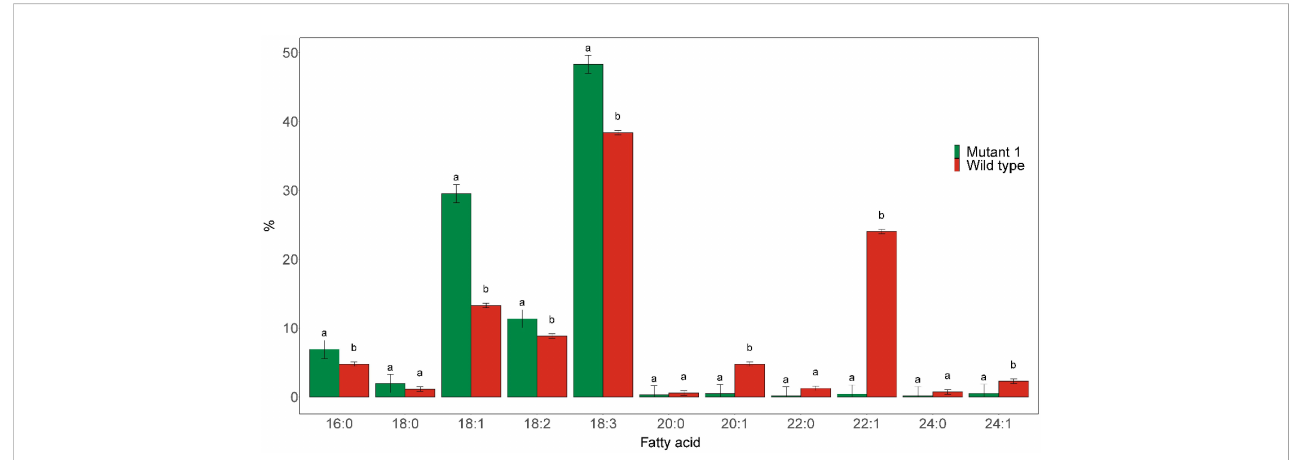
FIGURE 3 Major fatty acid compositions of seed oil derived from the seeds of homozygous fae1 Mutant 1, as shown in Figure 1, and wild type. Different letters indicate statistically signi fi cant differences at p <0.05 ( n =